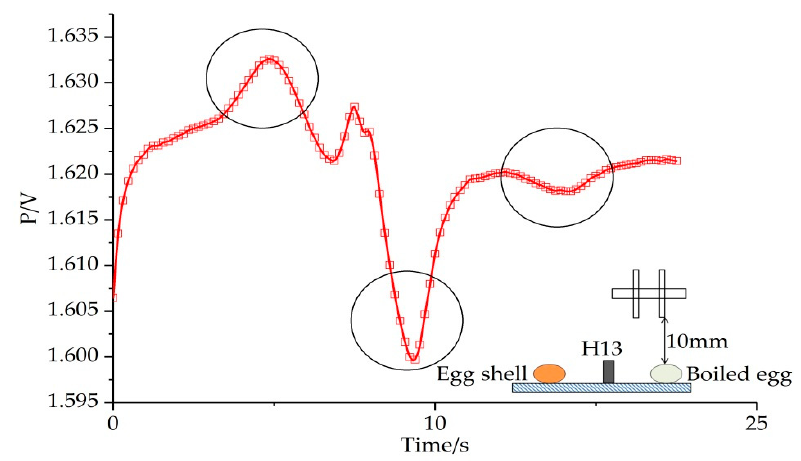
Figure 9. The electric image of identifying the boiled egg, H13, and eggshell. The three circles expressed the position of the poached egg, H13, and eggshell.